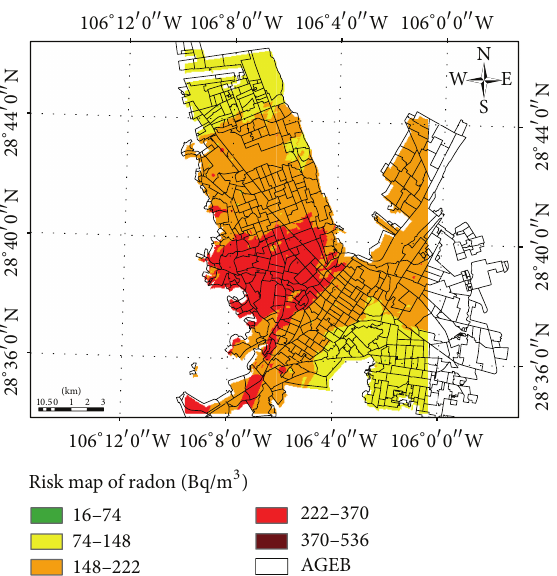
Figure 4: Radon exposure risk categories (Bq/m 3 ) versus AGEB (total population).